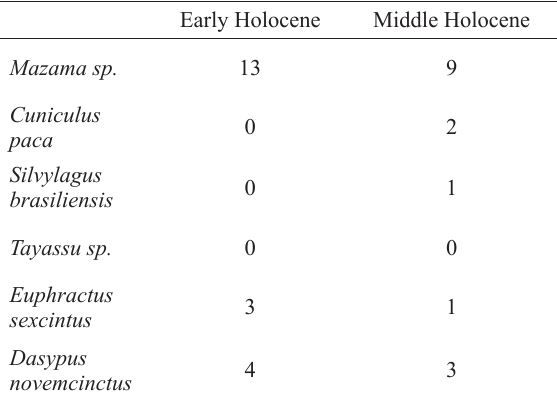
Test ts comparing the relative abundances (NISP and MNI) of Middle Holocene (MH) and Early Holocene (EH) taxa (classified as genus or species) after Perez (2009).